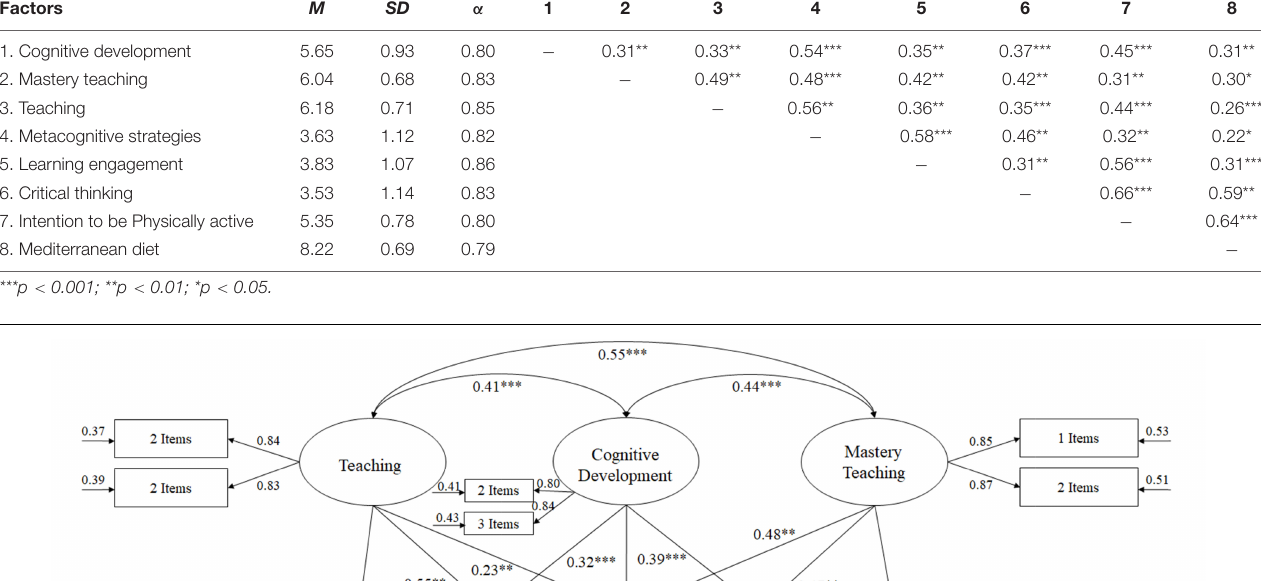
TABLE 2 | Descriptive statistics and correlations between all variables. Factors